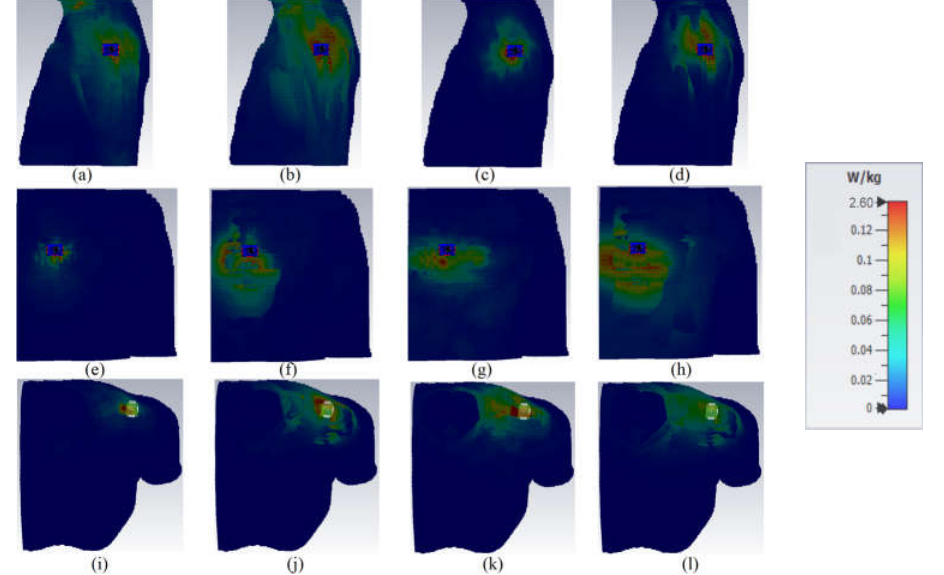
Figure 16. SAR evaluation of the proposed antenna at the proximity of human body tissue (( a ) at 3.4 GHz, 1 g; ( b ) at 3.4 GHz, 1 g; ( c ) at 5.6 GHz, 10 g; ( d ) at 5.6 GHz, 10 g).